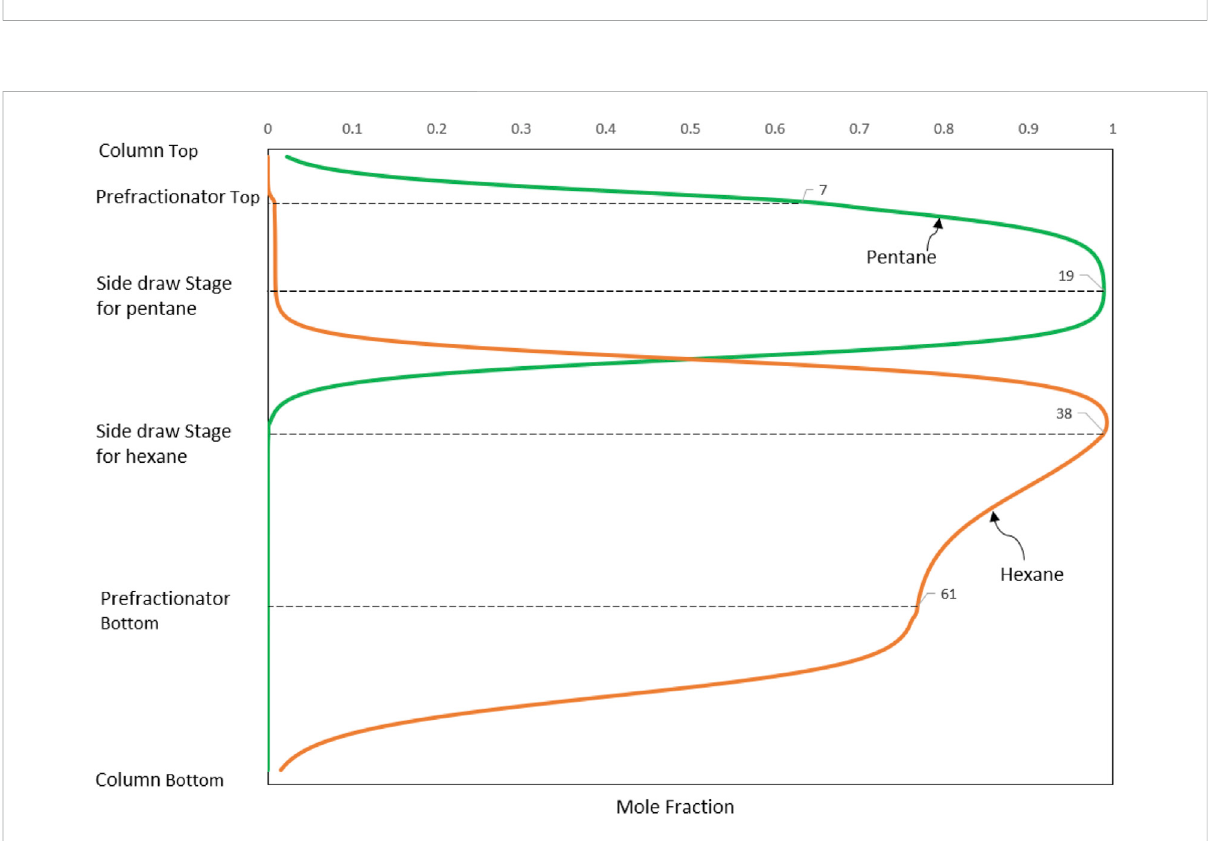
FIGURE 10 Composition pro fi les of Pentane and Hexane in the Kaibel column for Example